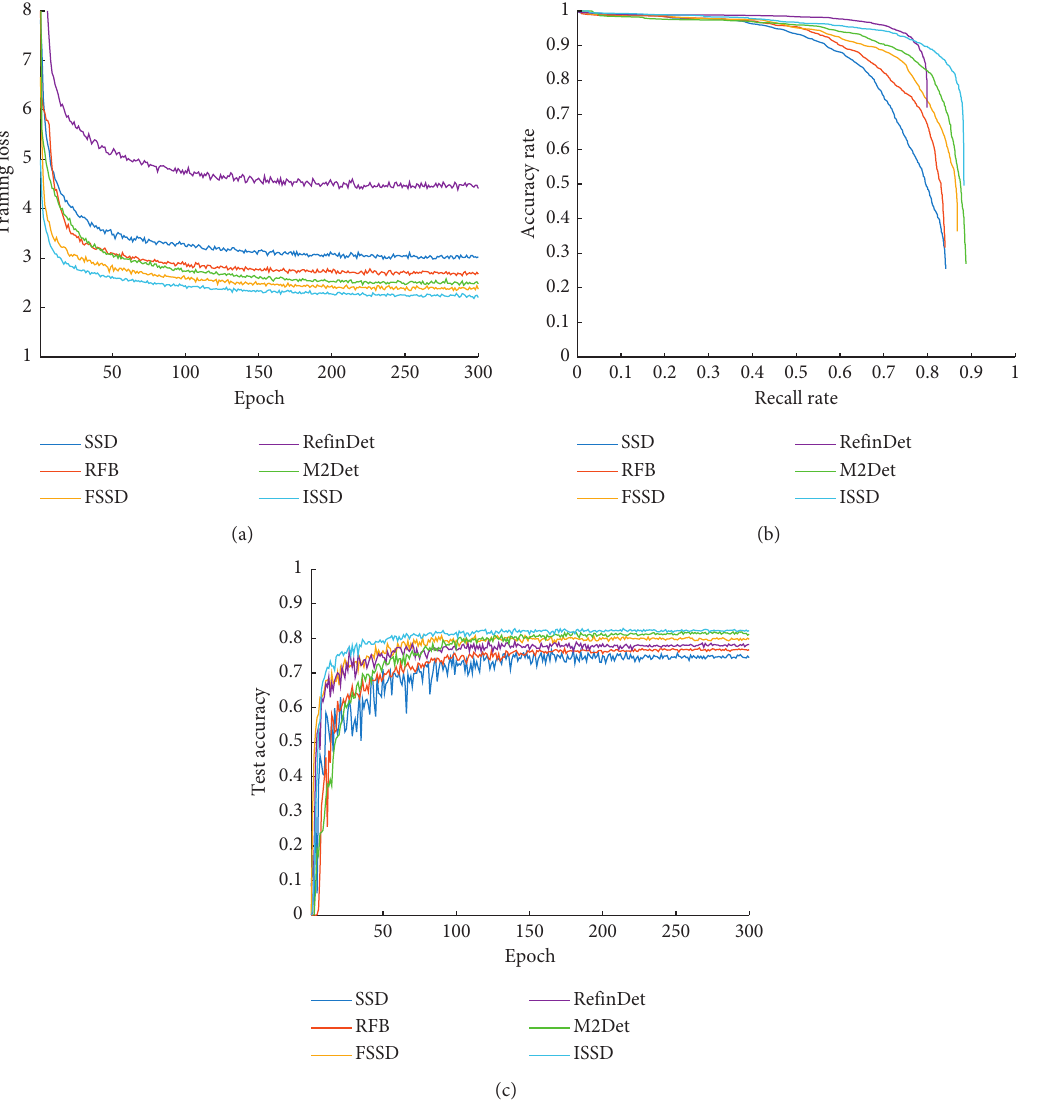
Figure 8: (a) Network loss function diagram; (b) P-R curve; and (c) accuracy curve of the test set. Table 2: Detection and identification performance of different test models on the sea urchin test